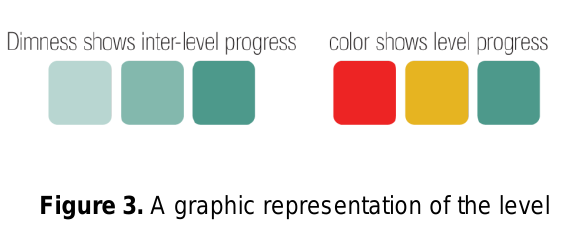
Figure 3. A graphic representation of the level progress given by the